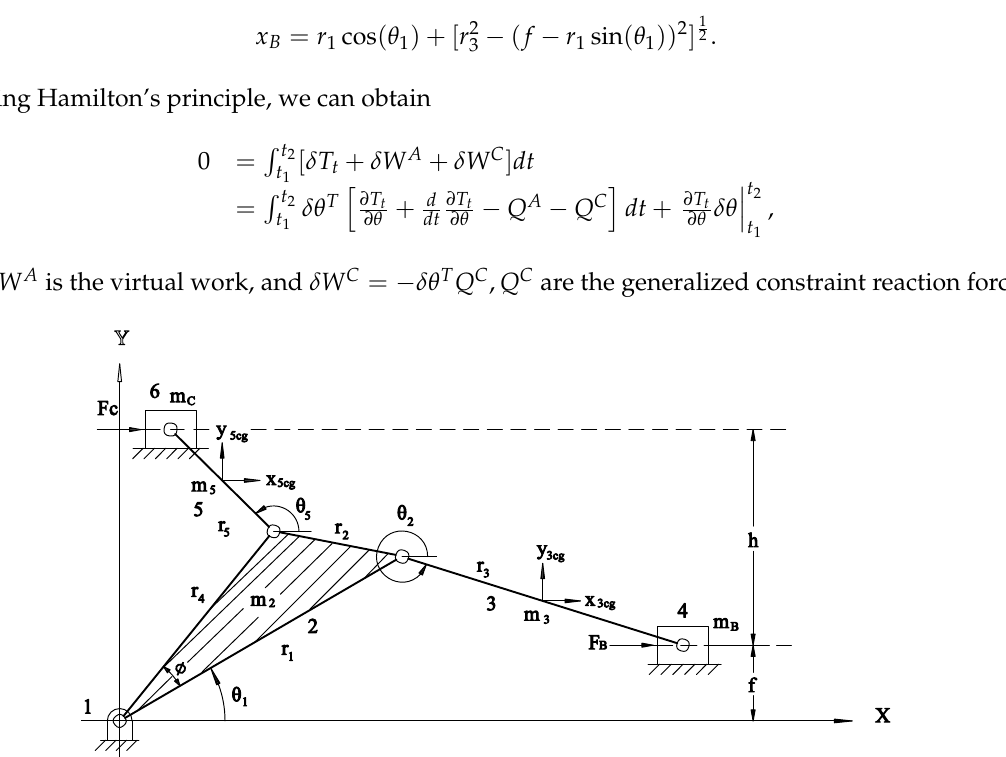
Figure 4. The physical model of TM . Establish a Cartesian coordinate system and set the origin at link one. F C and F B are the force on sliders B and C , respectively. m 2 , m 3 , m 5 , m B , and m C indicate the mass of links two, three, five, and sliders B and C , respectively. r 1 , r 2 , and r 4 indicate the three-side lengths of two, and r 3 and r 5 indicate the lengths of links three and five respectively; θ 1 , θ 2 , and θ 5 are the angular positions of link two, three, and five; h is the height between the two horizontal guides where sliders B and C travel; and f is an offset between links two and three